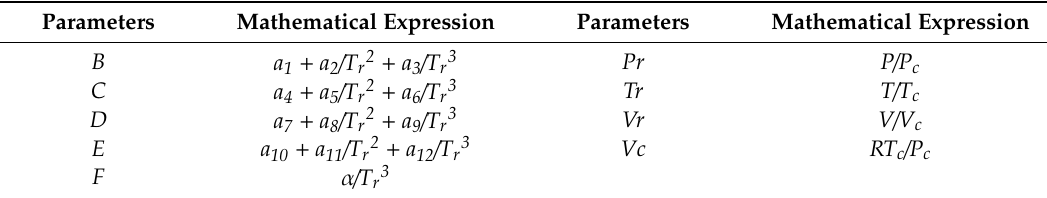
Table 1. Parameter expressions in the real gas state equation. Parameters a 1 –a 12 , α , β , γ , T c , and P c are compiled by Duan et al. (1992) [34]. Parameters Mathematical Expression Parameters Mathematical